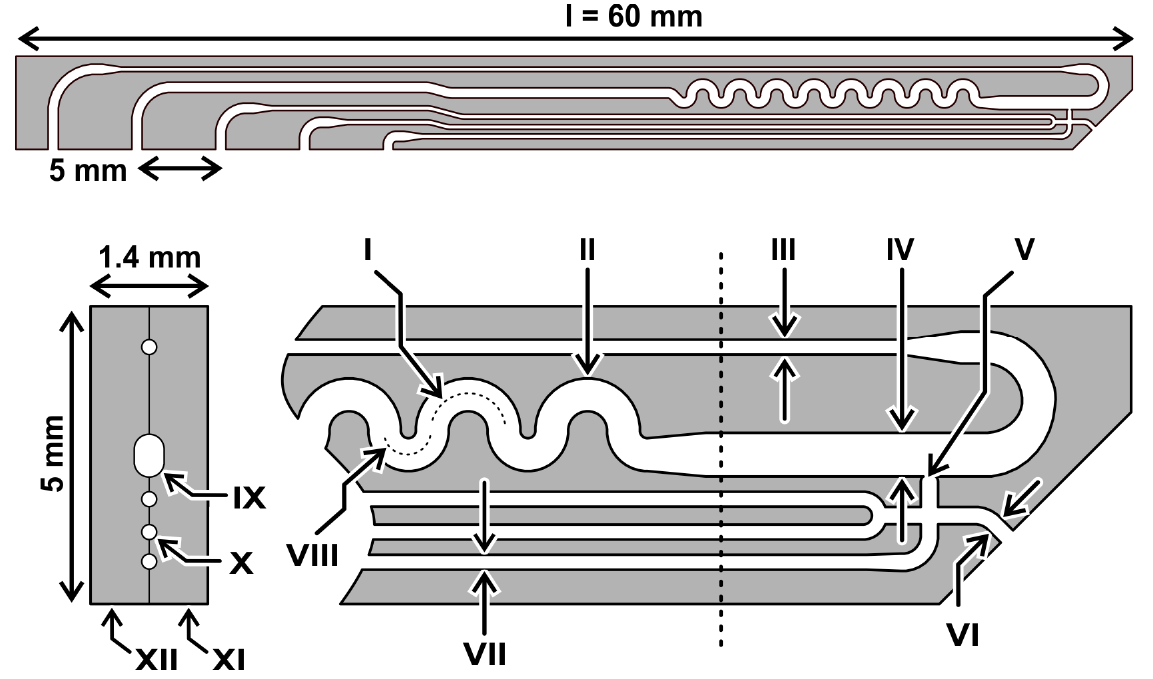
Figure 1. Dimension and layout of a DMPT. I: r = 600, d = 200; II: w = 550, d = 200; III: w,d = 100; IV: w = 730, d = 200; V: nozzle diameter appr. el 220, high 100; VI: w = 290, d = 100 VII: w, d = 100; VIII: r = 400; IX: d = 200; X: d = 100; XI = 1st half shell; XII = 2nd half shell (unit = µm, r = radius, w = width, d = etching depth).